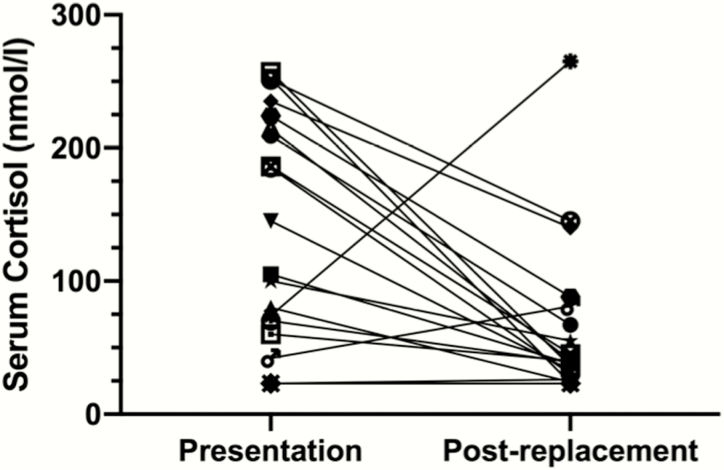
Newly diagnosed Addison disease. Peak serum cortisol at presentation with autoimmune Addison disease and at 1 month postdiagnosis. Serum cortisol concentration measured at first presentation of Addison disease is shown in the left-hand column linked to the cortisol concentration taken a median of 26 days later in the same individual in the right-hand column. A normal peak cortisol response on this assay is ≥ 550 nmol/L. The presentation serum cortisol fell from a median of 125 nmol/L (range < 23-257) to 39.5 nmol/L (range < 23-265), (P < 0.007; Mann-Whitney U test). To convert serum cortisol concentrations from nmol/L to μg/dL, divide by 27.6.